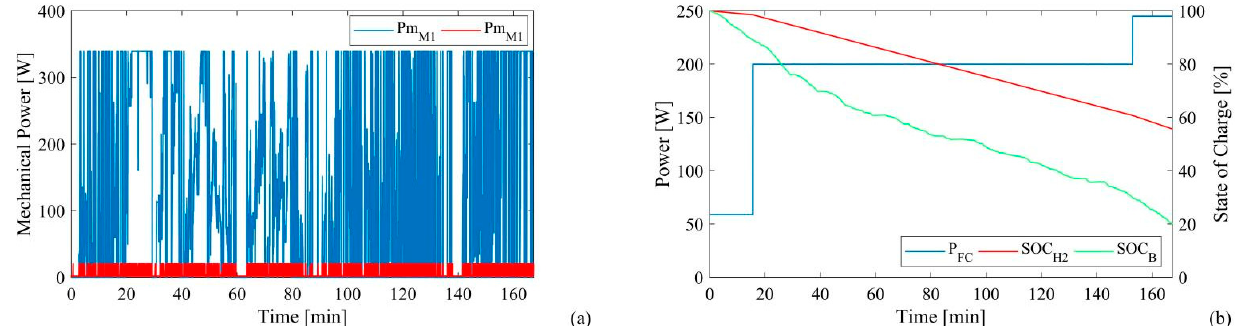
Figure 12. AMV performance in Journey 4, without control system correction: ( a ) Motor mechanical power trends; ( b ) Fuel cell power, hydrogen tank and battery state of charge trends.